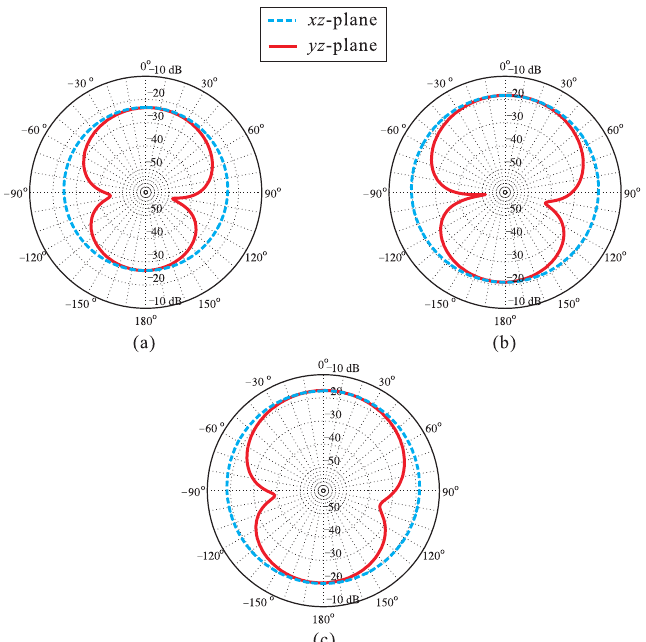
operating frequency of the antenna. Therefore, the back radiation is inevitably occurred.